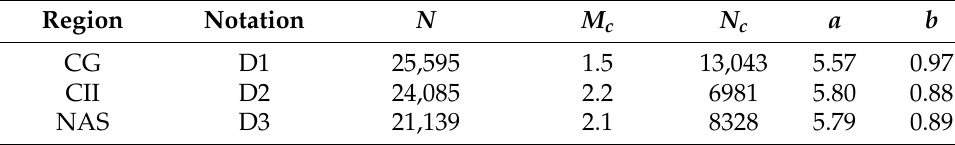
Table 3. The magnitude of completeness, M c , for the datasets of the three areas CG, CII and NAS, along with the productivity, a , and the b -value of the GR law. N and N c denote the initial number of events and the ones with M ≥ M c ,